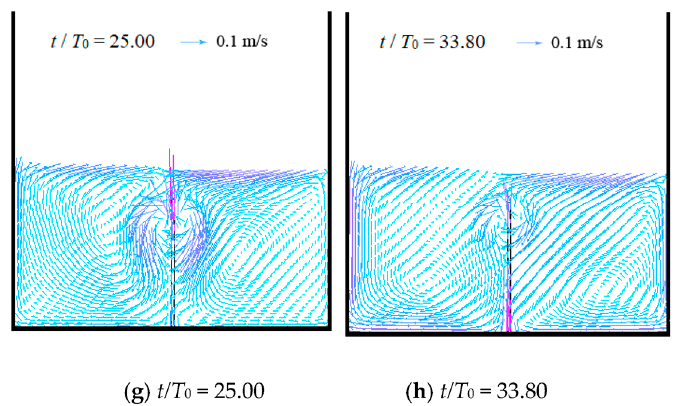
Figure 20. The fluid velocity fields of sloshing under the permeability coefficient λ = 0.098 m/s at different time instants. ( a ) t/T 0 = 2.70; ( b ) t/T 0 = 3.90; ( c ) t/T 0 =5.50; ( d ) t/T 0 =8.92; ( e ) t/T 0 = 14.00; ( f ) t/T 0 = 24.50; ( g ) t/T 0 = 25.00; ( h ) t/T 0 = 33.80.